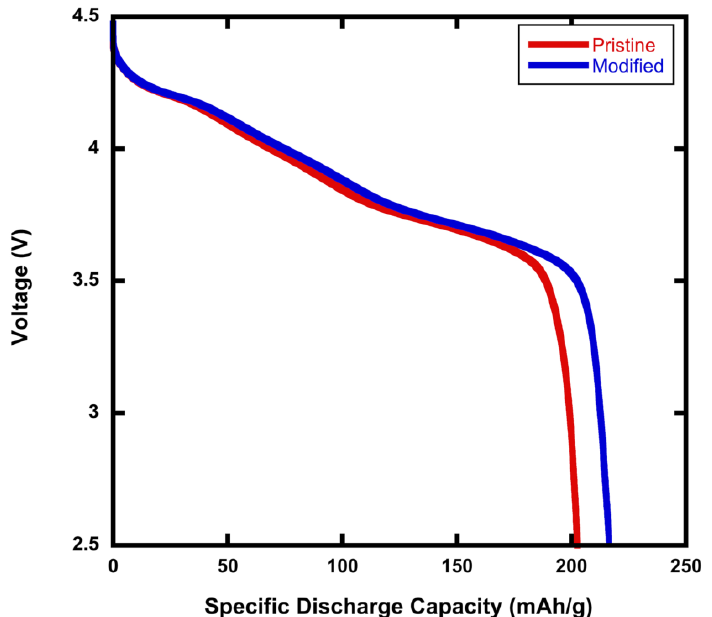
Figure 1. Initial discharge profiles for batteries made using pristine NMC811 and rGO/NMC811. In the plot legend, modified denotes rGO/NMC811 with 5wt% rGO. The rGO additive increases the discharge capacity by ∼ 5%. The measurement was conducted at 0.1C.